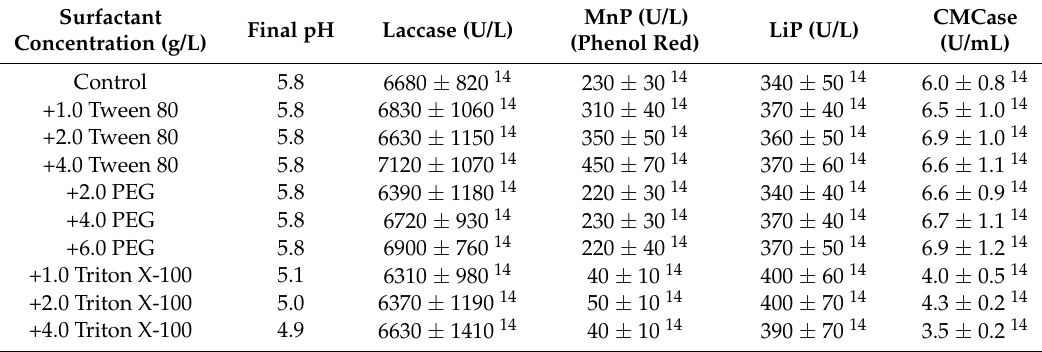
Table 4. The effect of addition of surfactants on LME and CMCase production by C. gallica 142 in submerged fermentation of mandarin peels.